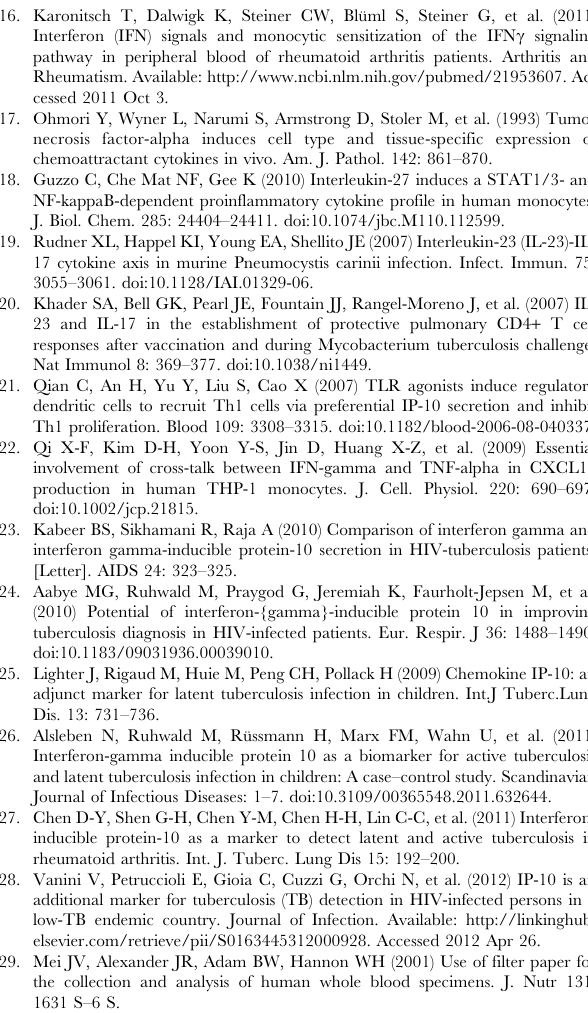
reference (0 days) sample 6 100. Samples were within our acceptance range of 70–130%, indicating samples can be stored at room temperature for prolonged periods without significant loss in recovery. Table S10 Stability of IP-10 in plasma with repeated freeze thaw cycles. The ability of IP-10 in plasma to tolerate freeze-thaw cycles was assessed by freezing and thawing up to 10 times. Samples were thawed at room temperature and left for minimum 2 hours before refreezing. There was at least 24 hours between each freeze-thaw cycle. %Recovery is calculated by comparing the value of the treated sample to the freshly thawed control sample x100. Samples were within our acceptance range of 70–130%, indicating samples can undergo at least 10 freeze-thaw cycles without major loss in